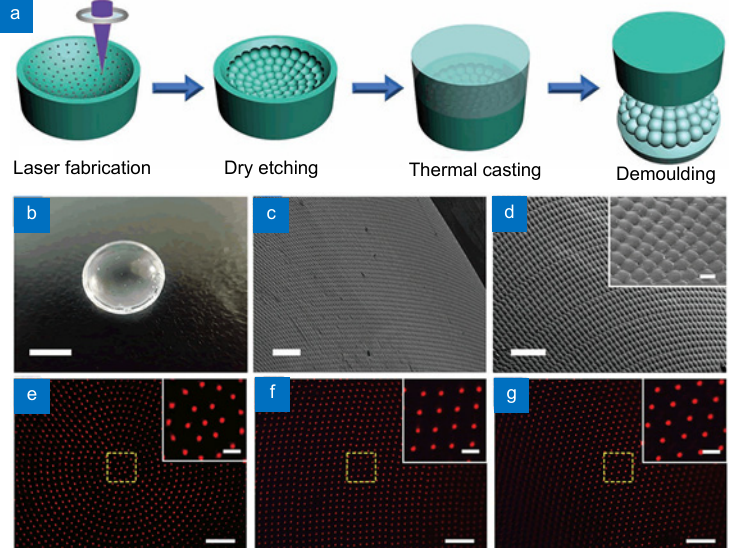
Fig. 9 | K9 glass compound eyes. ( a ) Diagram of the fabrication of sapphire compound eyes and the thermal replication of K9 glass compound eyes. ( b ) Optical image and ( c,d ) SEM of the centimeter-sized K9 glass compound eye. Insert in (d) is the amplified SEM image. ( e–g ) Optical images of focal spots with incident angle of 0 o , 30 o and 45 o , respectively. Figure reproduced from (a–g) ref. 100 , WILEY-VCH Verlag GmbH & Co. KGaA,